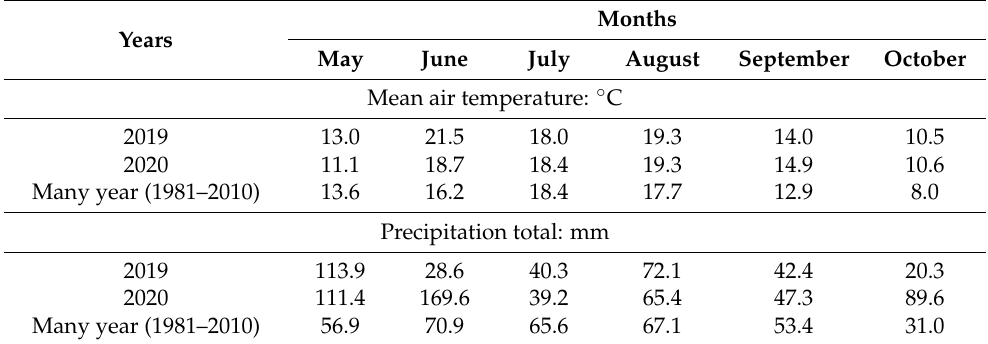
Table 2. Mean air temperature and precipitation total in the carrot growing